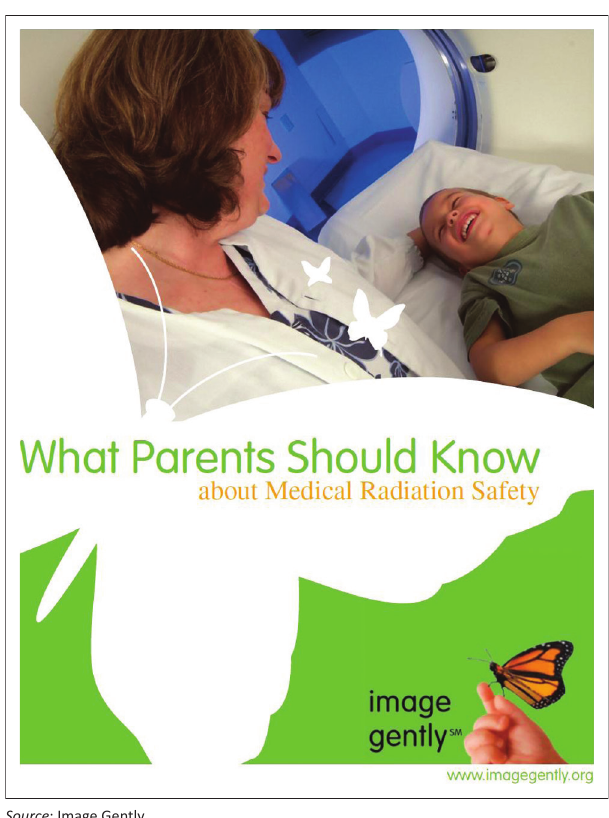
FIGURE 3: Parent brochure describing medical radiation and radiation safety from Image Gently for patients and families. Notice that the colours are bright and the photograph has a smiling child with a health worker. The full brochure is available at http://www.imagegently.org (Reprint permission granted by the Image Gently